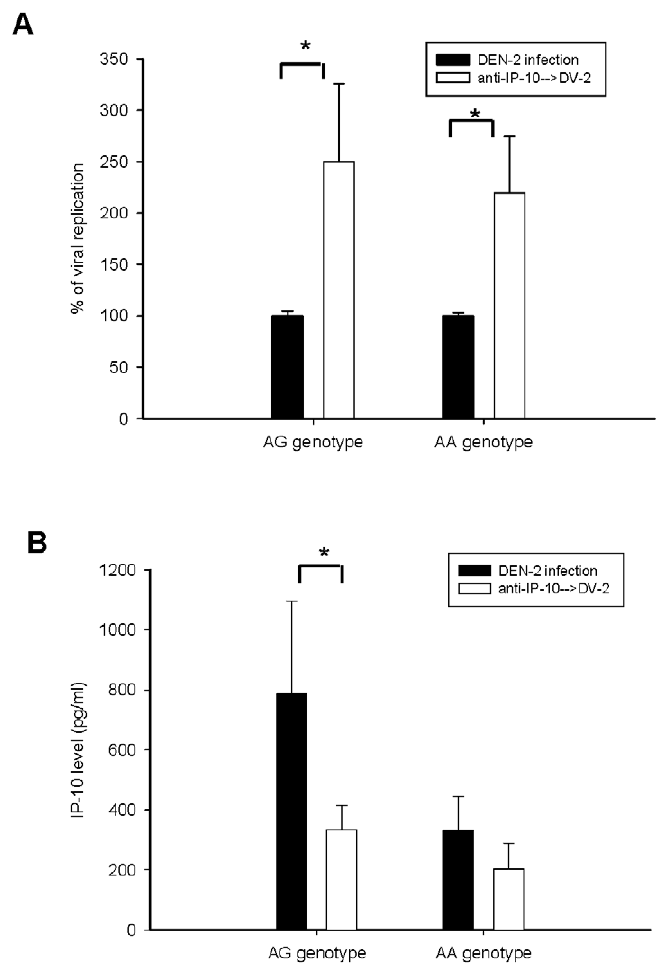
Figure 4. IP-10 production by MDDCs involved in the viral replication of DEN infection. MDDCs were mock-infected or DEN infected (MOI=5) after preincubation, with and without anti-IP-10 neutralizing antibody (10 m g/mL) for 30 min. Total RNA was extracted from MDDCs and the supernatants were collected 24 h post-infection. The percentage of viral replication (A) and the production of IP-10 levels (B) following DEN-2 infection were significantly higher by MDDCs from individuals with AG genotype than from individuals with AA genotype. Following DEN-2 infection, the production of IP-10 by MDDCs from individuals with AA genotype was not significantly different between those with and without anti-IP-10 neutralizing antibody. The results are shown as mean 6 SEM from three independent experiments (n=7). Statistical values were determined by Wilcoxon signed-rank test. Asterisk (*) indicates a significant difference ( p , 0.05).